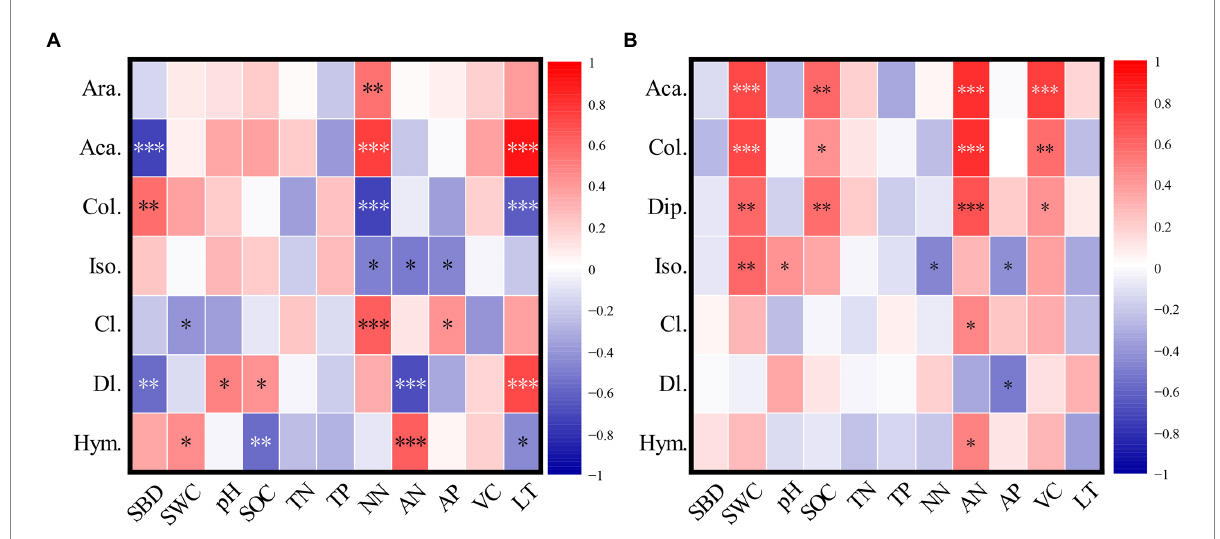
FIGURE 7 Pearson correlation coefficients between main groups of soil arthropods and environmental factors ( A is the burned habitats; B is the unburned habitats). Ara., Araneae; Aca., Acari; Col., Collembola; Dip., Diplura; Iso., Isoptera; Cl., Coleoptera larvae; Dl., Diptera larvae; Hym., Hymenoptera; SWC, Soil water content; SBD, Soil bulk density; pH, Soil pH; SOC, Soil organic carbon (SOC); TN, Soil total nitrogen; TP, Soil total phosphorus; AP, Available phosphorus; AN, Ammonia nitrogen; NN, Nitrate nitrogen; VC, Vegetation coverage; LT: Litter thickness. * p < 0.05; ** p < 0.01; *** p < 0.001.